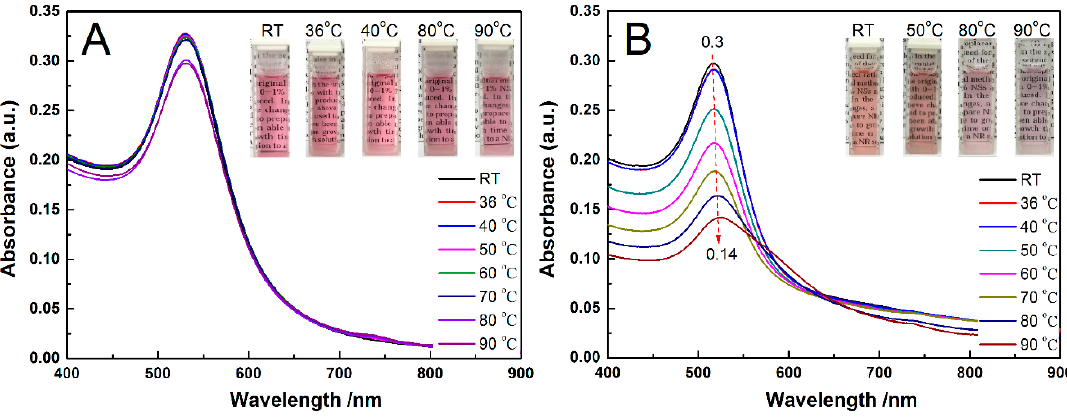
Figure 2. The change in the UV-Vis spectra with temperature for AuNPs-PNIPAM ( A ) and AuNPs ( B ).